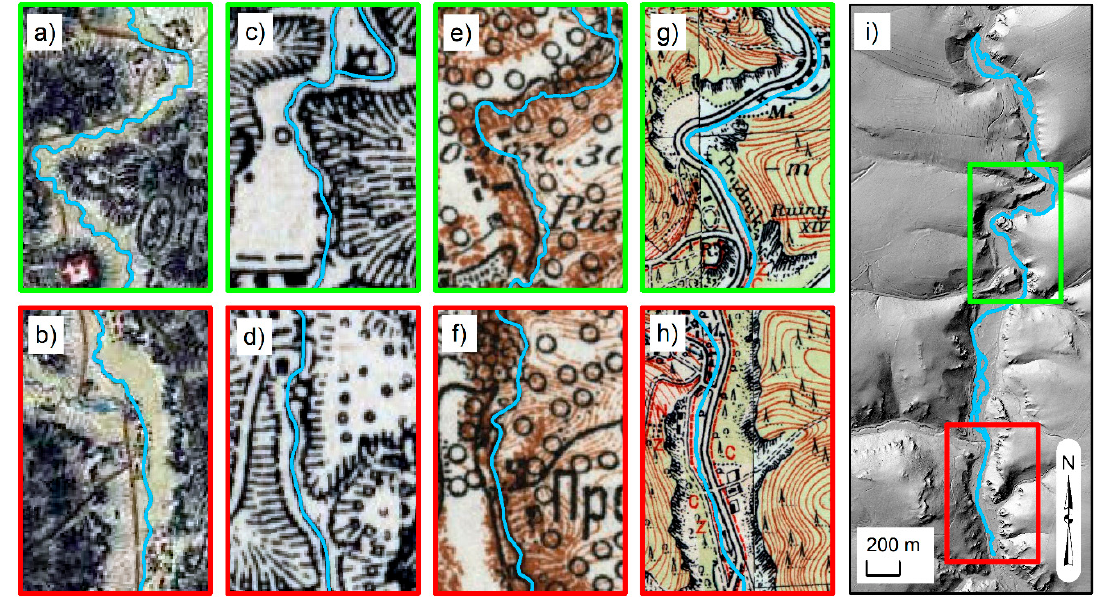
Figure 4. Old maps of the Pr ˛adnik River in the Ojc ó w National Park. ( a , b ) Josephine map of Galicia ( c , d ) Ojc ó w Bazaar ( e , f ) Russian “two-vierst” map ( g , h ) Military Geographical Institute (WIG) 25k, ( i ) location of the river parts. Green rectangle—represents ( a , c , e , g ). Red rectangle—represents ( b , d , f , h